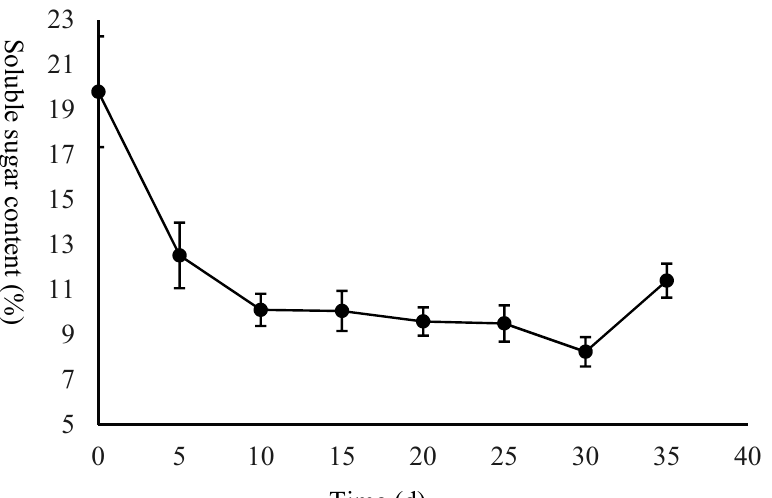
Figure 3. The changes in the soluble sugar content during germination. Values represent the mean ⎯ X ± SD of three biological replicates.